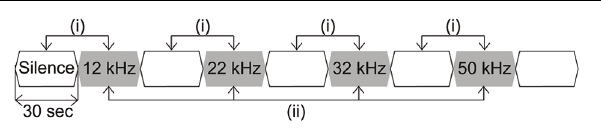
FIGURE 1 | Schematic diagram of long-lasting pure tone stimuli used in this study. Long-lasting pure tones with a duration of 30 s, including a 5-ms rise/fall, with an intensity of 60 dB SPL and frequencies from 12 to 50 kHz (Table 1) . Each of the pure tones was presented in a pseudorandom order and interleaved with a silent block of 30